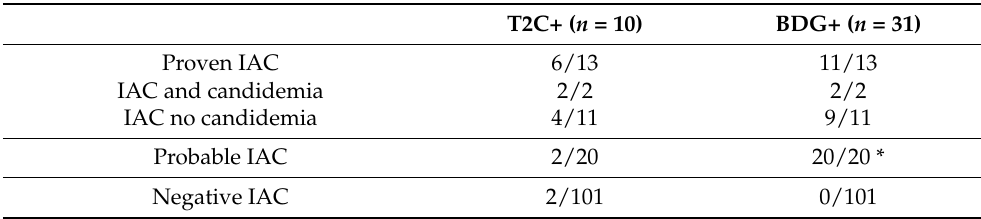
Table 3. Performances of T2C and BDG for IAC criteria, n = 134.